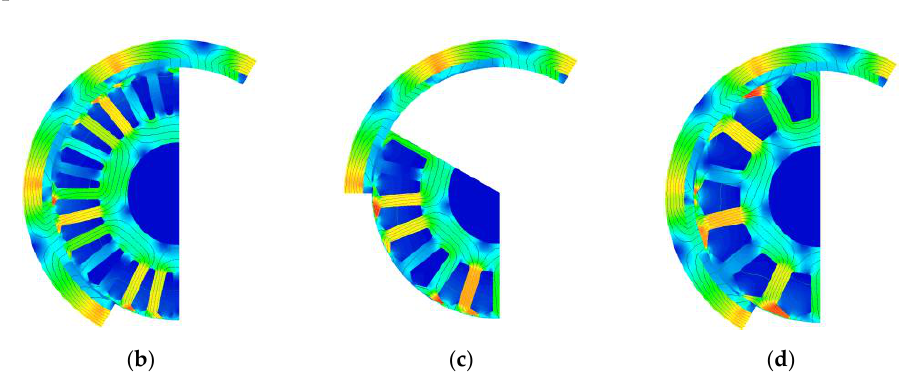
Figure A1. Flux density distribution in the initial models: ( a ) 42/6 and q = 1, ( b ) 28/6 and q = 2 / 3 , ( c ) 21/6 and q = 1 / 2 , ( d ) 14/6 and q = 1 / 3